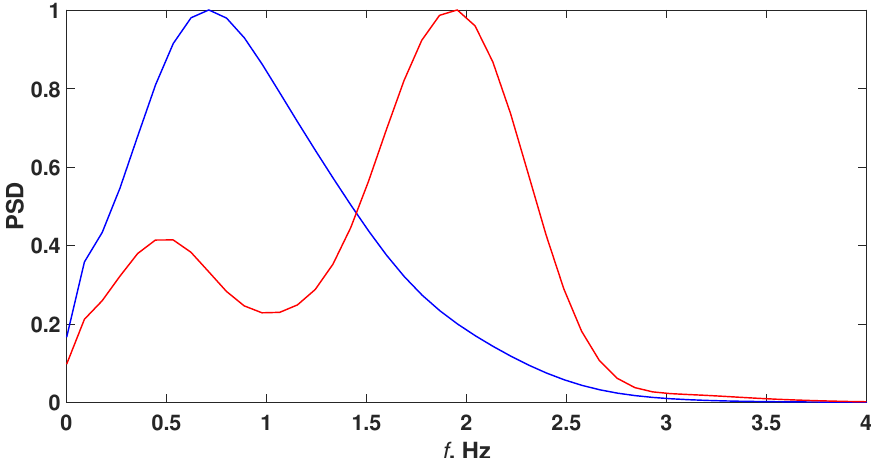
Figure 10. Fourier spectra of wavelet spectrograms slices f cur = 4 Hz. The red line is the Fourier Spectrum of the ES slice; the blue line is the Fourier spectrum of the chewing artifact